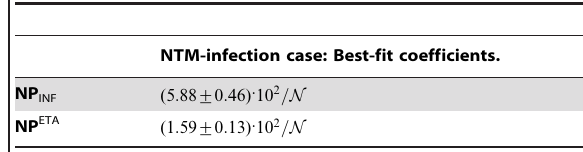
Table 2. NTM-infection case: Best-fit coefficients.